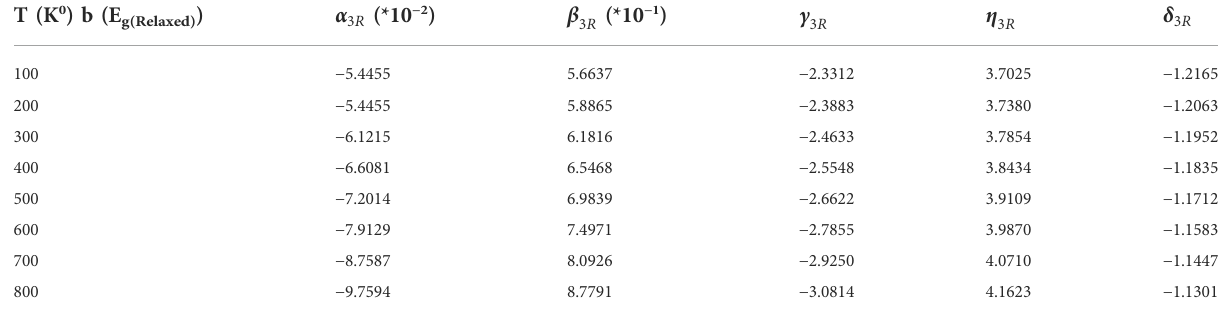
TABLE 7 Fitting parameters for “ b ” under the relaxed condition at different temperatures.